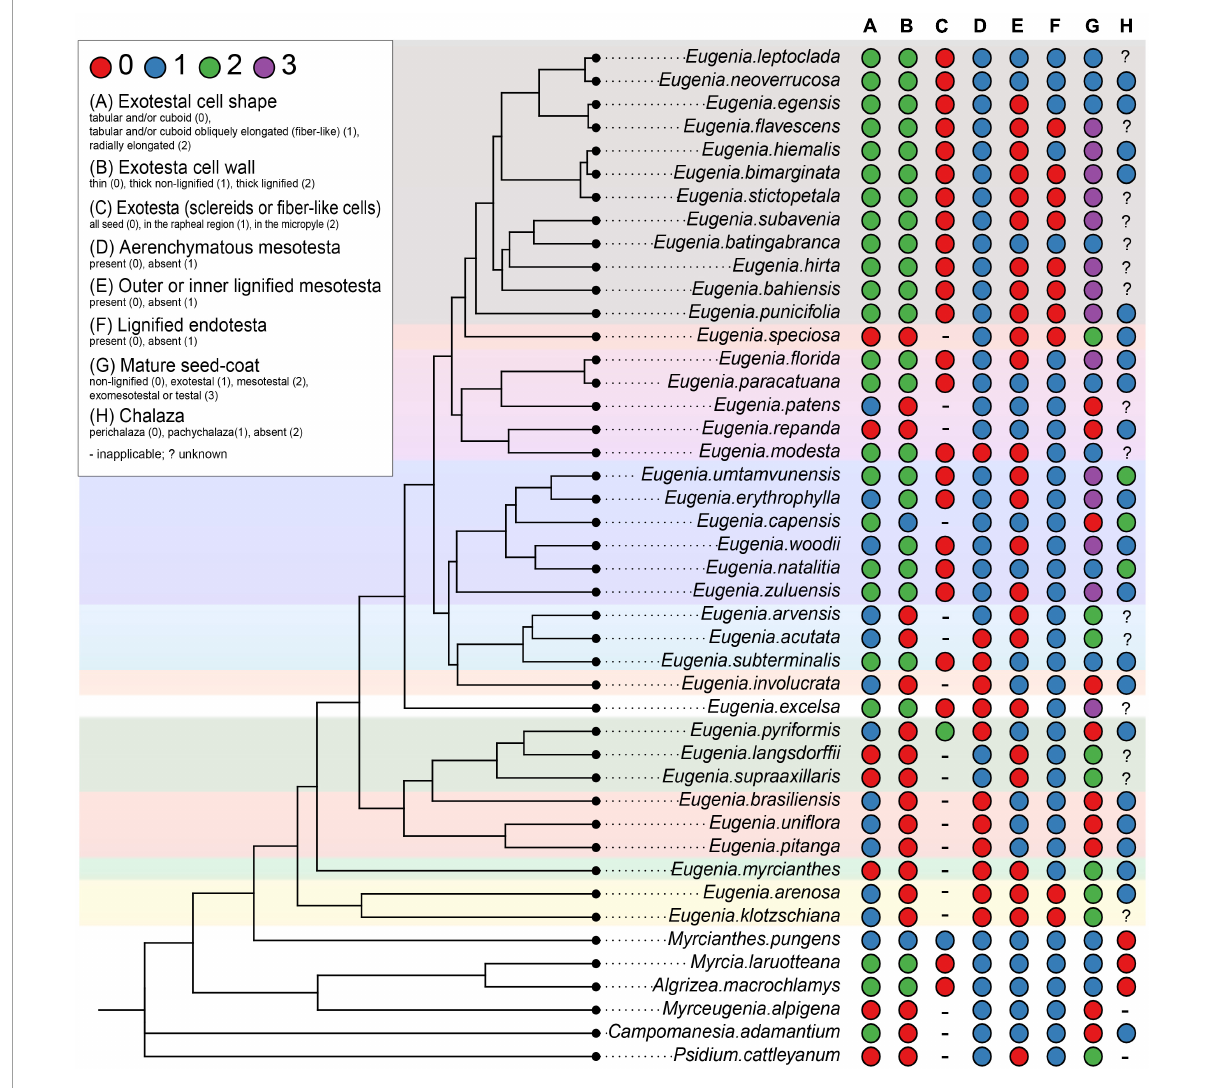
FIGURE7 Eugeniinae phylogeny with species character states of mature seed: exotestal cell shape (A) , exotesta cell wall (B) , exotesta surface (C) , mesotesta (D) , outer and/or inner mesotesta (E) , endotesta lignification (F) , mature seed coat (G) , and chalaza (H) ( Eugenia sect. Pseudeugenia ; E. sect. Hexachlamys ; E. sect. Eugenia ; E. sect. Pilothecium ; E. sect. Excelsae ; E. sect. Phyllocalyx ; E. sect. Schizocalomyrtus ; E. sect. Jossinia ; E. sect. Racemosae ; E. sect. Speciosae ; E. sect. Umbellatae